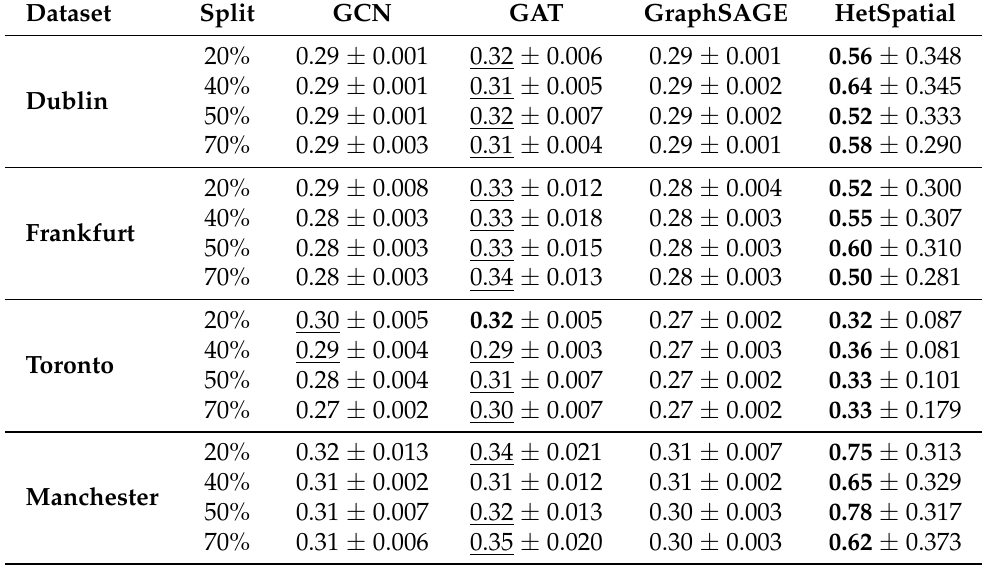
Table 5. Table showing the macro F1-score results for street type inference. The values in bold and underlined represent the best and second best performing approaches for each city/split,